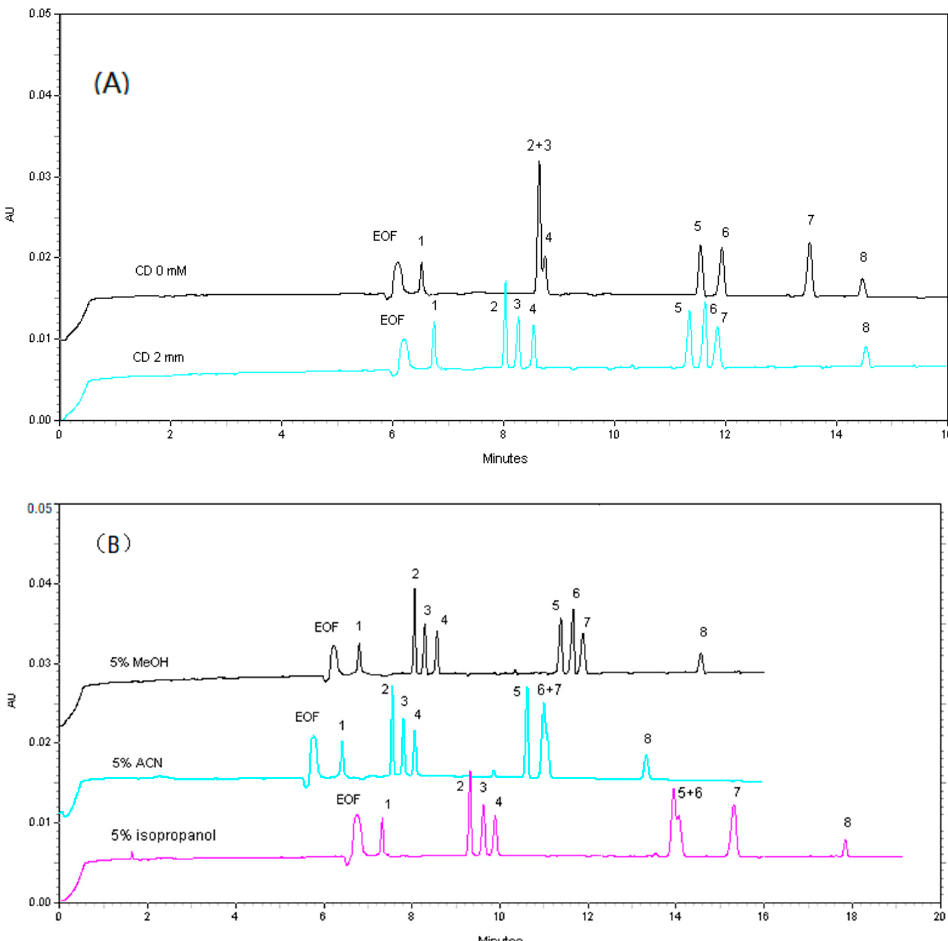
Figure 3. Effects of β -CD and organic modifiers on the migration time and separation of analytes. ( A ) 40 mM borax with different concentrations of β -CD and 5% ( v / v ) methanol at pH 10.30; ( B ) 40 mM borax with 2 mM β -CD and different organic modifiers at pH 10.30. Labels of compounds are the same as for Figure 2.